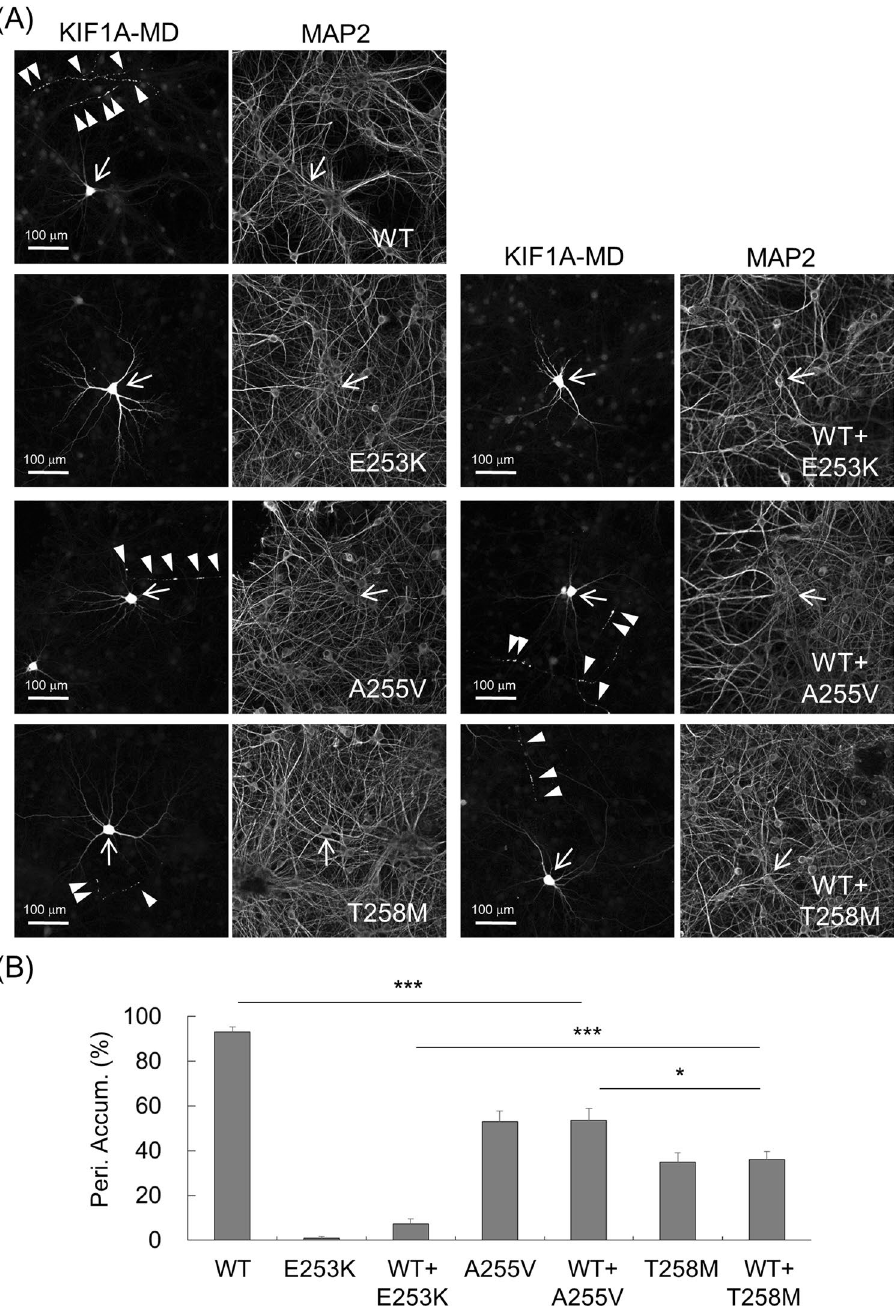
Figure 7. Dominant negative effect of p.T258M mutation on KIF1A motor activity. ( A ) WT KIF1A-MD- EGFP showed considerably reduced peripheral accumulation when co-expressed with KIF1A-MD-T258M (arrow heads). Neuronal cell bodies (arrow) and dendrites were visualized by immunofluorescence staining for MAP2. ( B ) Quantification of the peripheral accumulation of KIF1A-MD proteins (mean ± s.e.m.). The distal distribution of KIF1A-MD was analyzed as described in Methods. Significant decreases are indicated ( *** p < 0.0001: * p <